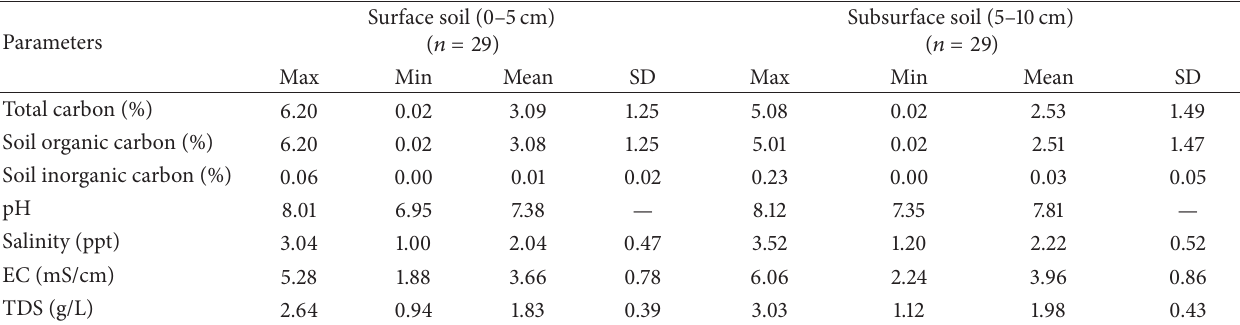
Table 1: Descriptive statistics of total carbon, soil organic carbon, soil inorganic carbon contents, and soil characteristics in surface and subsurface soils.